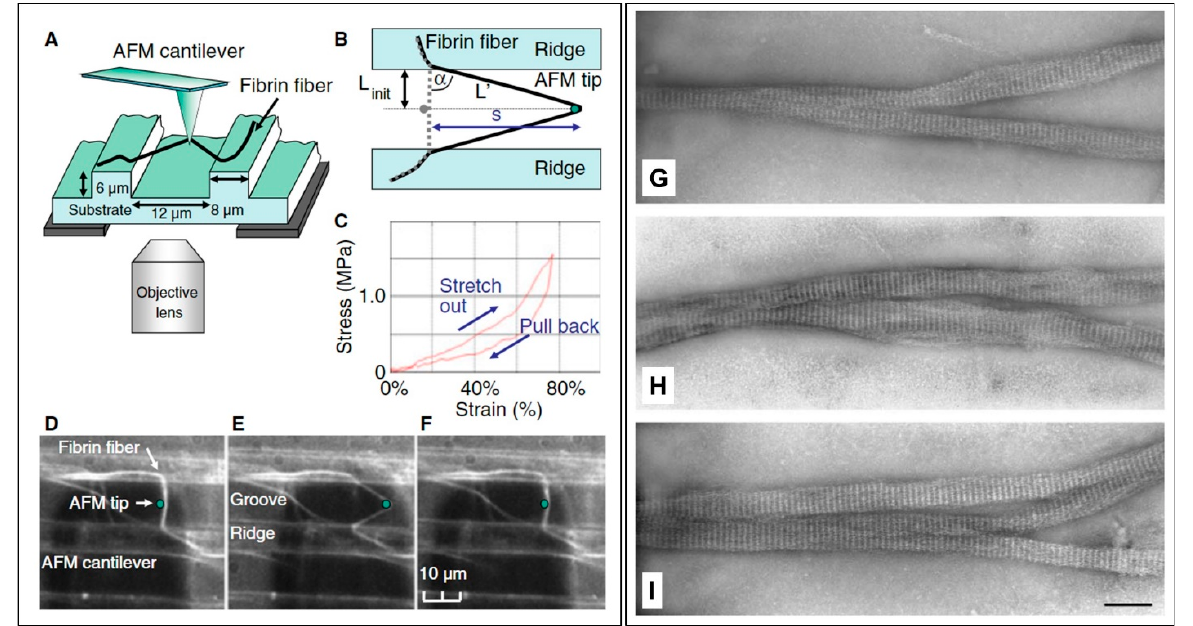
Figure 4. ( A ) Schematic of the atomic force microscope (AFM) sitting on top of the inverted optical microscope. ( B ) Top view of the stretched fiber. The initial and stretched states are in dotted gray and solid black, respectively. ( C ) Typical fibrin fiber stress–strain curve. ( D – F ) Fluorescence microscopy film stills of a stretching experiment. The fiber is anchored on two ridges (brighter, horizontal, 8 μ m wide bars) and suspended over a groove (darker, horizontal, 12 μ m wide bars); the AFM cantilever appears as a 35 μ m wide, dark rectangle; the AFM tip is indicated as a green dot. Reprinted/adapted with permission from Ref. [19]. 2010, International Society on Thrombosis and Haemostasis. ( G–I ) TEM images of negatively contrasted fibrin fibers showing the substructure of branch points. Most branch points consist of three fiber segments of nearly equal diameters that join at a small acute angle with band patterns aligned. The band pattern with a repeat of 22.5 nm is characteristic of fibrin. Scale bar is 0.2 microns. Reprinted/adapted with permission from Ref. [26]. 2004, Elsevier.